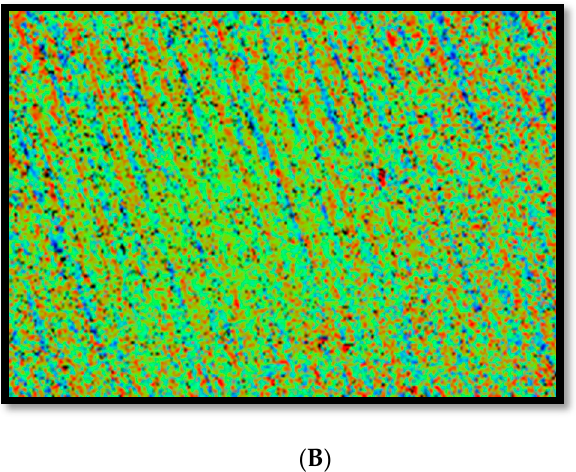
Figure 6. Surface roughness micro-graphs for the fifth ( A ), and seventh ( B ) firing